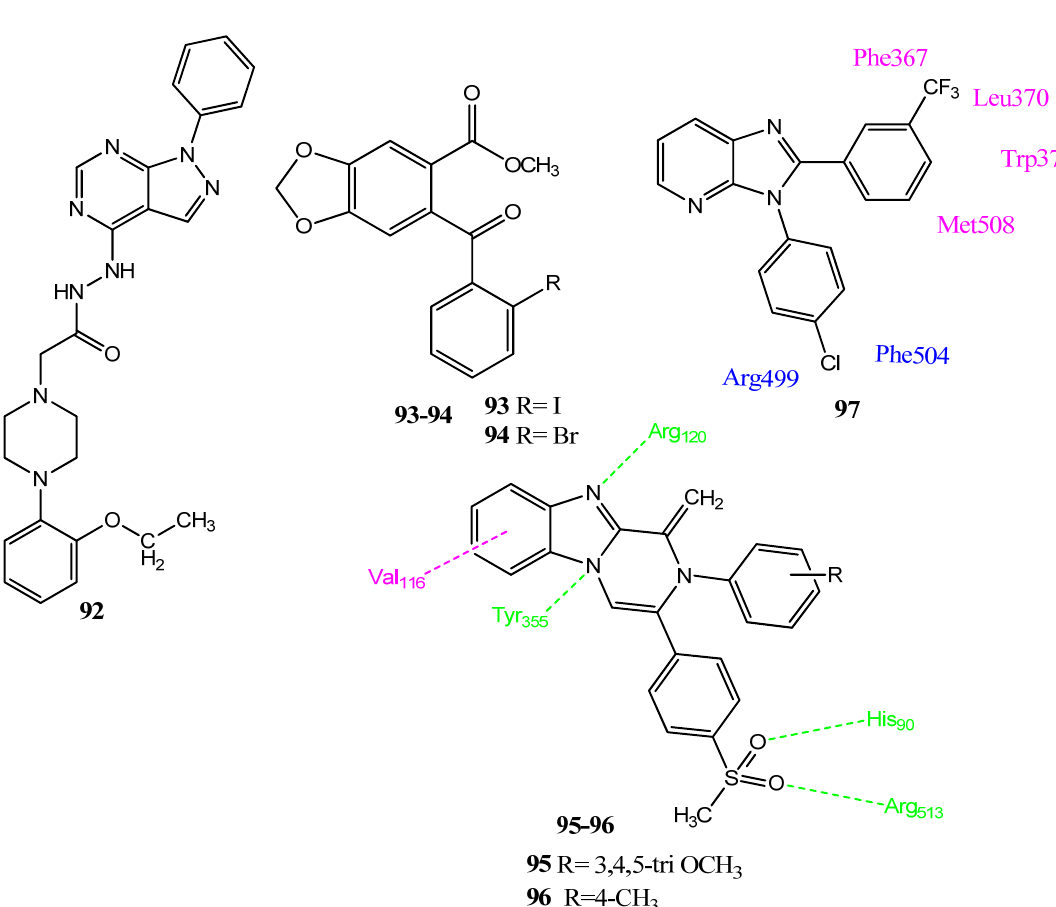
Figure 18. Xanthone, naphthoquinone, and benzothiazine derivatives.